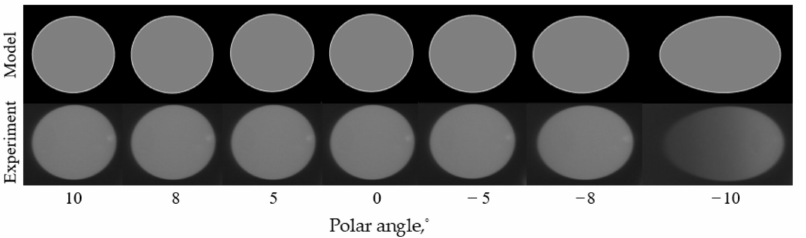
Figure 9. Simulated (upper row) and experimental (lower row) images with the AOTF tuned to λ = 632.8 nm ( f = 72.84 MHz) for different angles of incident light in the polar plane.